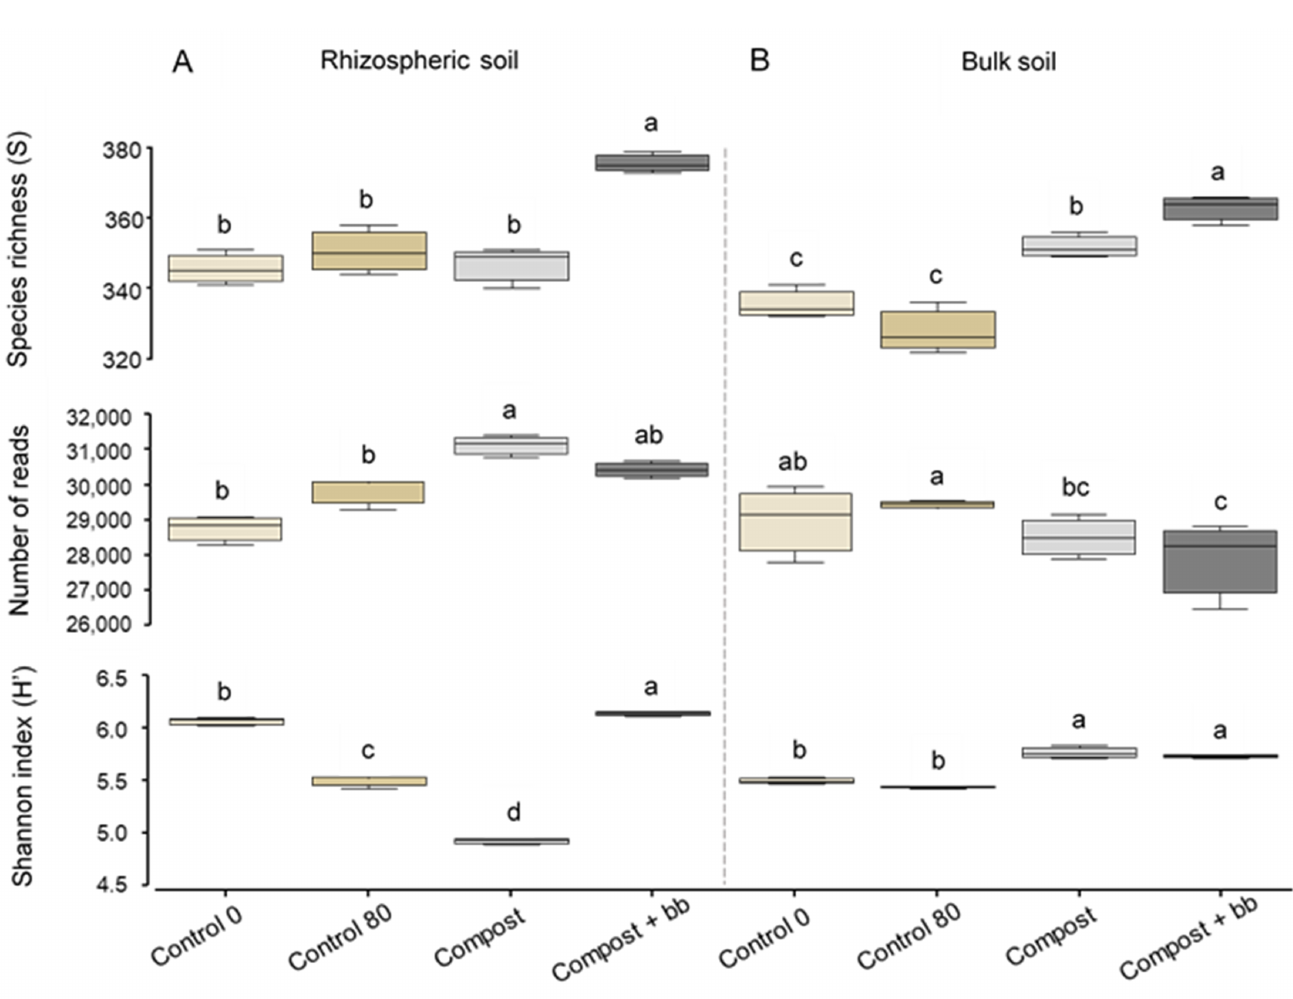
Figure 5. Boxplots showing the distribution of diversity indices for the bacterial community in each treatment in ( A ) rhizospheric and ( B ) bulk soil. S: N ◦ of ASV/number of amplicon sequence variant; number of reads for the bacterial community; H’: Shannon index. The lower and upper bounds of the boxplots show the first and third quartiles (the 25th and 75th percentiles), the middle line shows the median, and the whiskers above and below the boxplot indicate inter-quartile ranges. Different letters indicate significant differences for p -value below 0.05 according to Tukey’s HSD